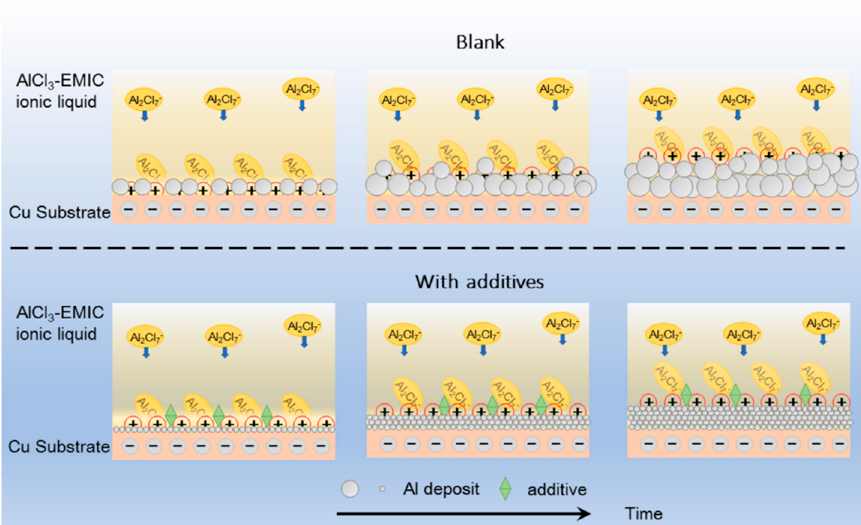
Figure 10. Schematic diagrams of the Al coating electrodeposition process from AlCl 3 -EMIC ionic liquids containing no (blank) and additives.